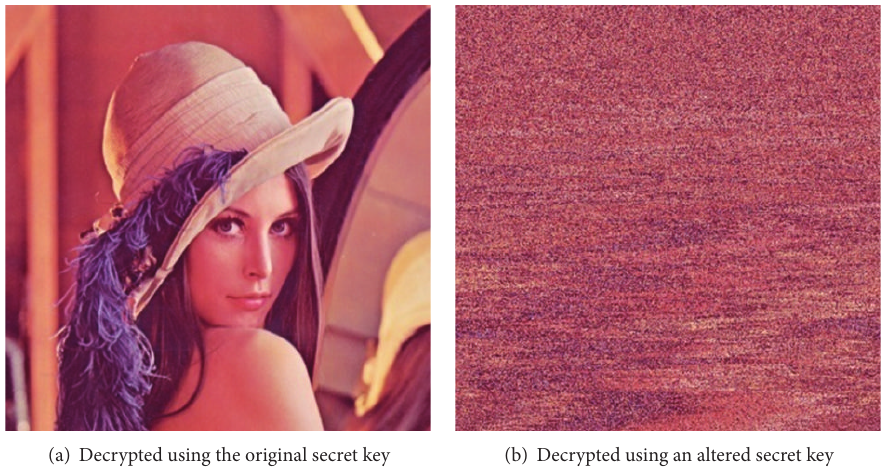
Figure 8: Images that resulted from decrypting the encrypted Lena